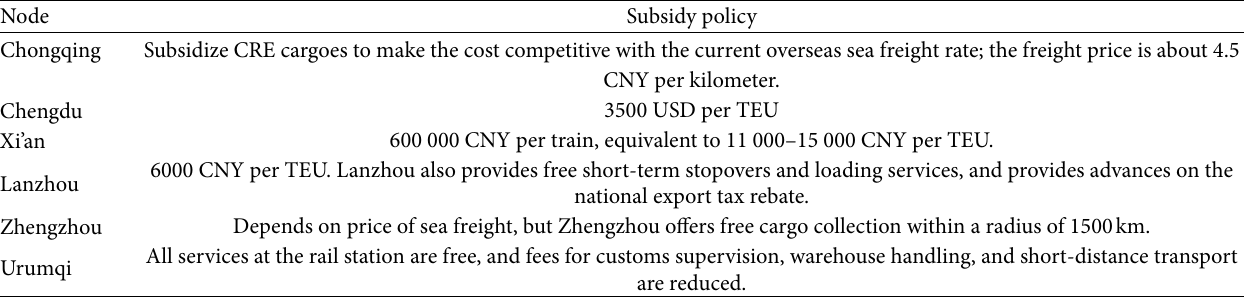
Table 5: Local subsidy policies under CRE (TEU, twenty-foot equivalent unit).